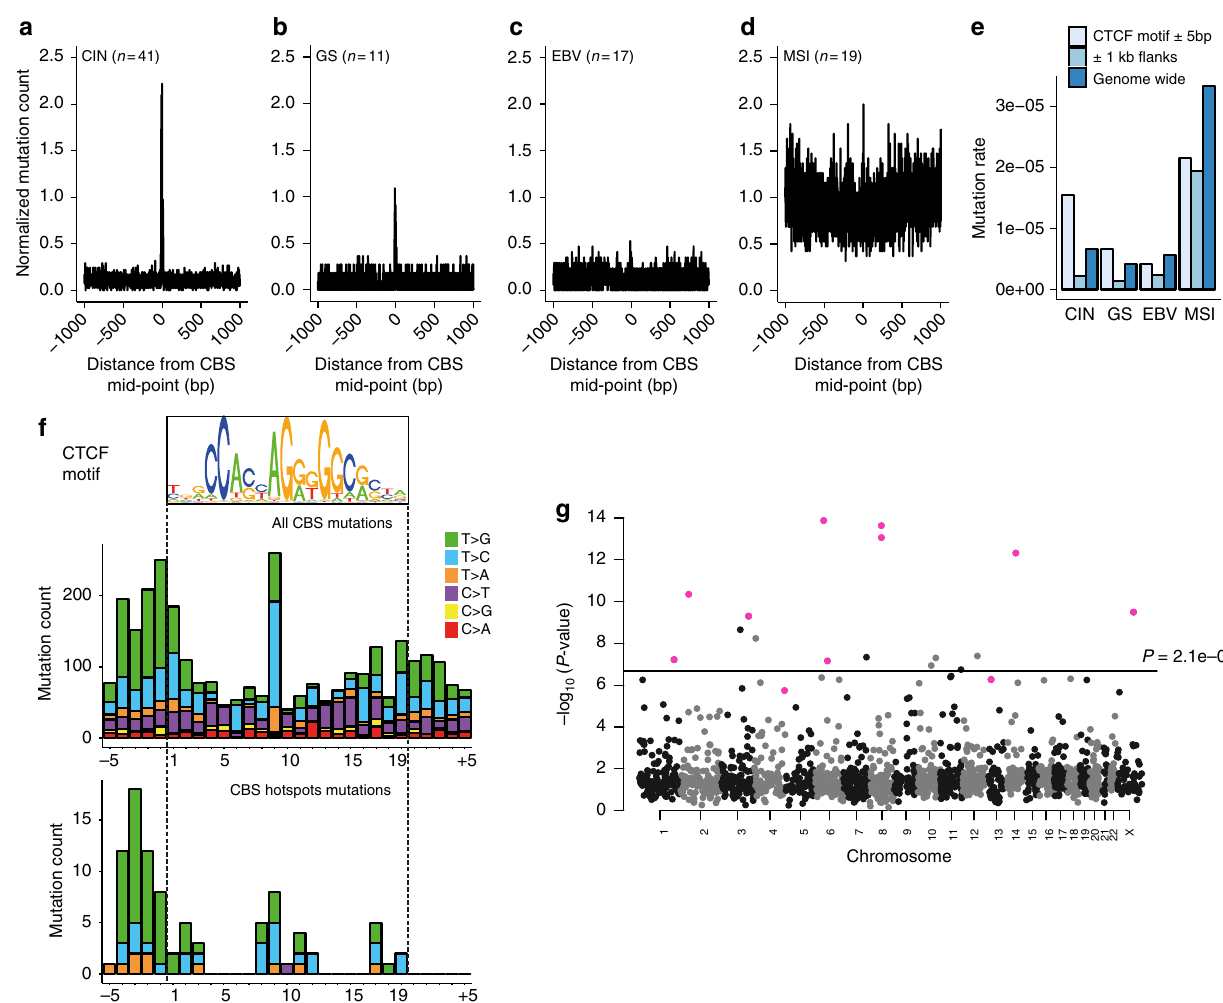
Fig. 4 Analysis of CBS mutations in different gastric cancer subtypes. a – d Mutation count per tumor around CBSs in the four gastric cancer subtypes. e Elevated mutation rates at CBSs compared to fl anking regions. f Somatic substitution patterns within CTCF motifs for hotspot mutations and all mutations, respectively. g The negative log P -values of mutation recurrence of all CBSs evaluated with a CBS-speci fi c background model. CBS hotspots identi fi ed in Fig. 3a are highlighted in magenta. The horizontal line marks the Bonferroni adjusted P -value of